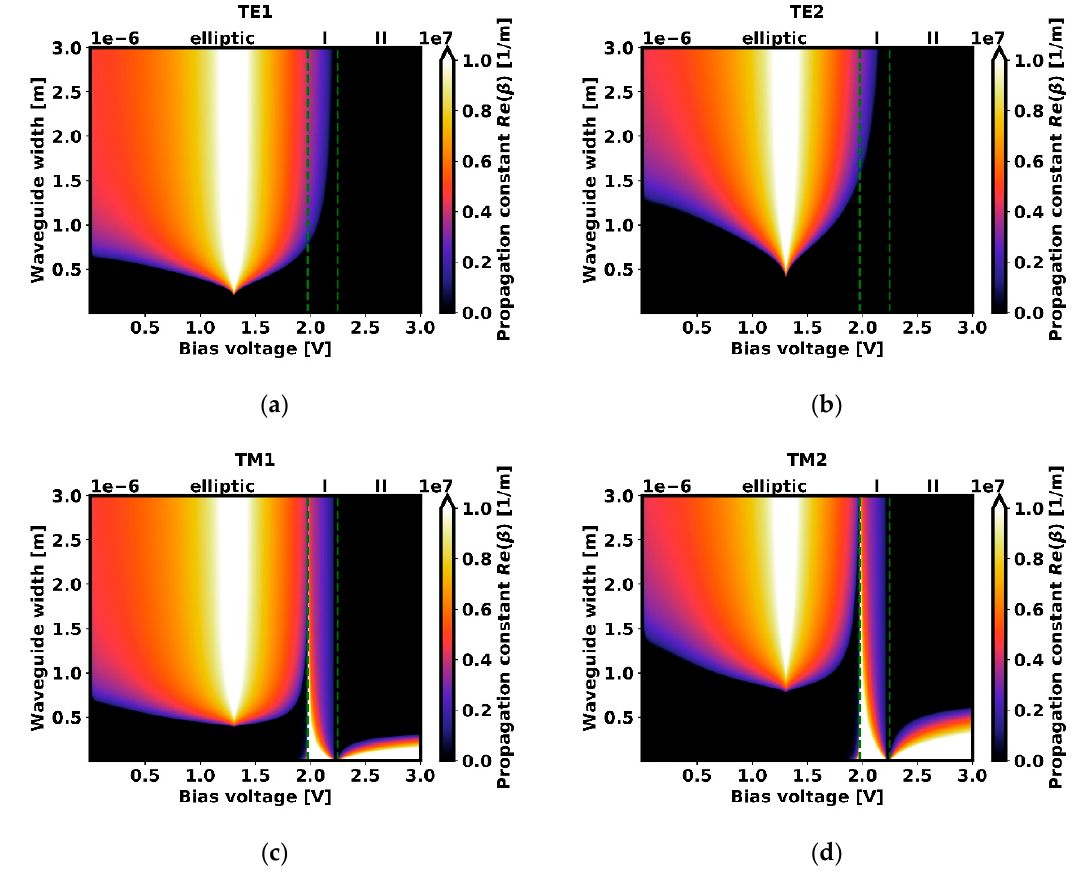
Figure 7. Map of propagation constant values for TM1 and TE1 ( a , c ), and TM2 and TE2 ( b , d ) for a perpendicular configuration at 1.55 µ m dependent on the waveguide width the biasing voltage. Black areas indicate regions where propagation is prohibited.